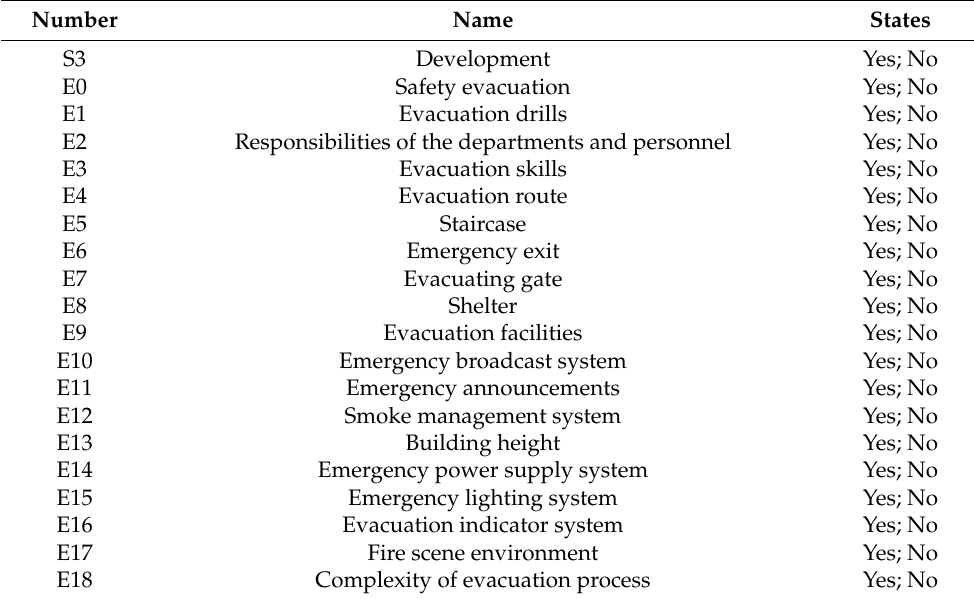
Table A8. The name and states of the nodes related to safety evacuation in Bayesian